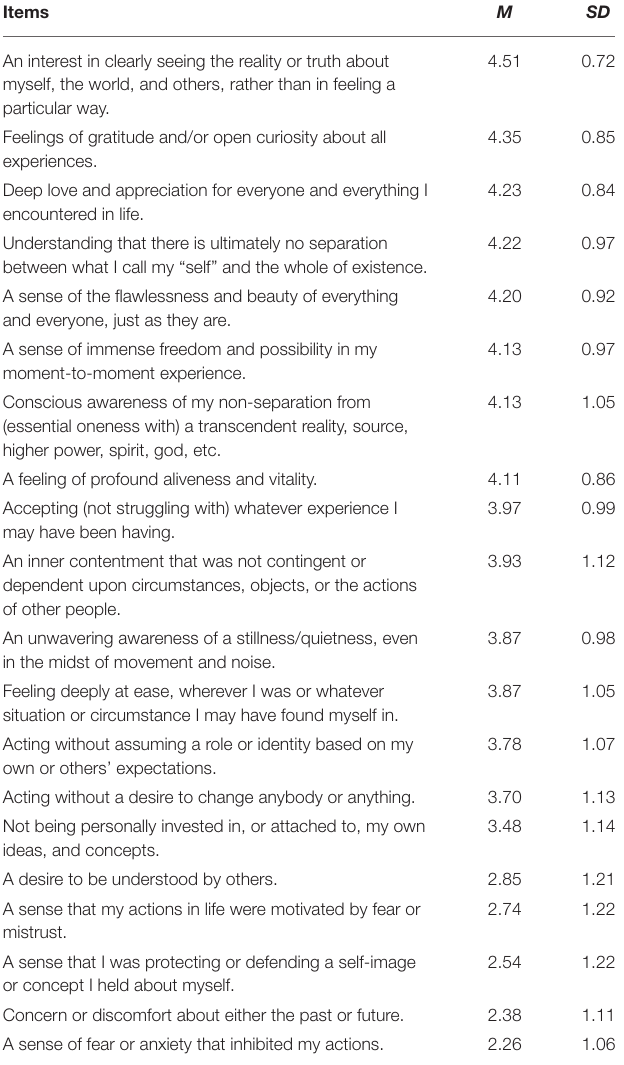
TABLE 2 | Highest to lowest mean scores of the 20-item Nondual Embodiment Thematic Inventory (NETI; Butlein, 2005), relating to the phenomenological features of SSA/SKA ( N =